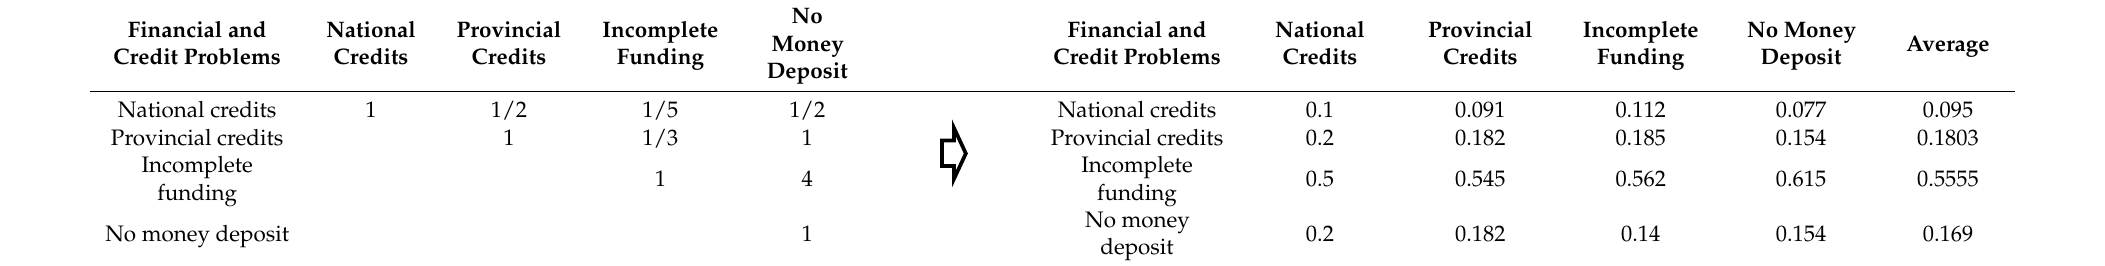
Table 3. The pairwise comparisons matrix for main criteria. Table 4. The pairwise comparisons matrix for lands’ funding. Table 7. The pairwise comparisons matrix for financial and credit problems.